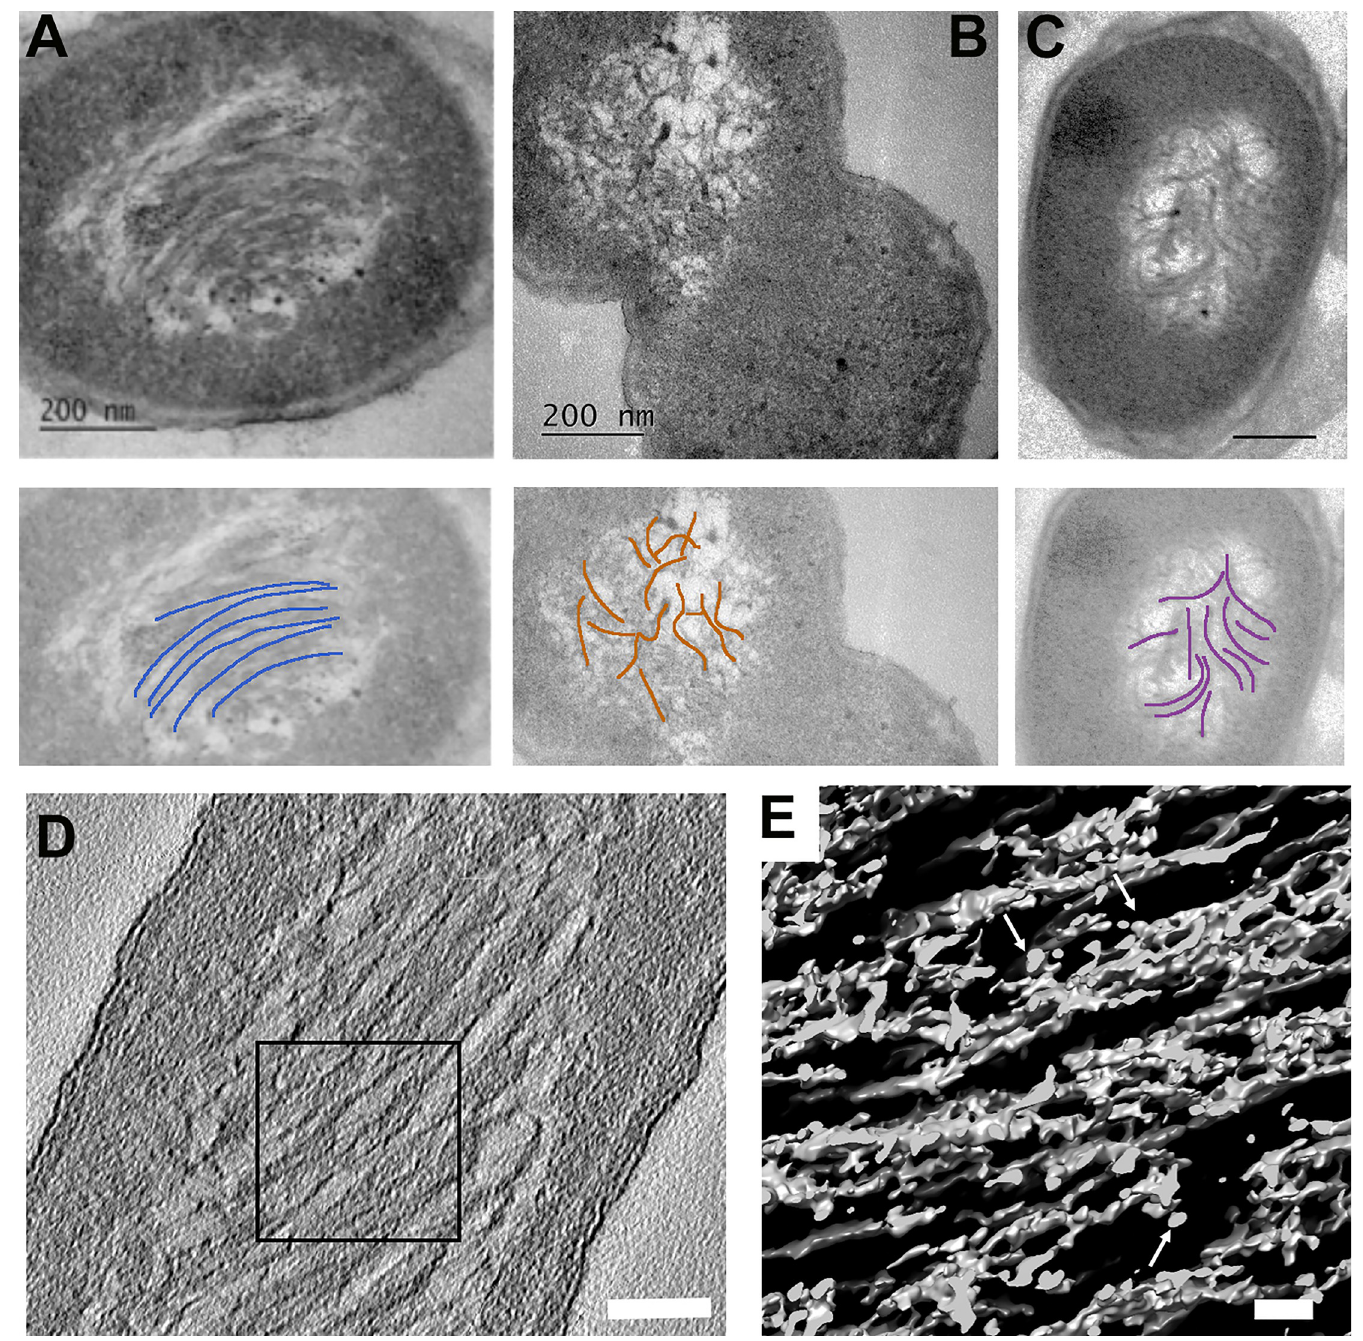
Fig 4. Morphology of the DNA-Dps liquid crystalline assemblies in dormant E . coli cells. (A) E . coli strain Top10/pBAD-DPS growing on M9 media, with induced Dps production in the linear growth phase, age 7 months; (B, C) E . coli strain BL21-Gold(DE3)/pET-DPS, same conditions as in (A); below, each micrograph– corresponded schematic of DNA strand distribution (blue–cholesteric order, orange–isotropic order, purple–nearly cholesteric order). (D) Central section through the tomogram of an E . coli cell with a cholesteric liquid crystalline structure. Bar –100 nm. (E) 3D representation of the liquid crystal , marked on (D) with a black frame. White arrows are pointing to the Dps. Bar– 30